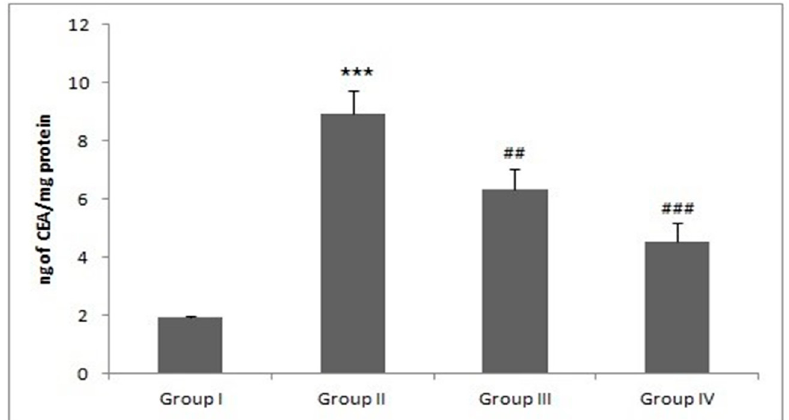
Figure 2. Piperine treatment mitigates CEA production. In group-II, the CEA level was increased significantly ( *** p < 0.001) as compared to control group. Treatment with Piperine (30 and 60 mg/kg b. wt.) significantly attenuated CEA level in group III ( ## p < 0.01) and group IV ( ### p < 0.001) as compared to group II ( n = 10).